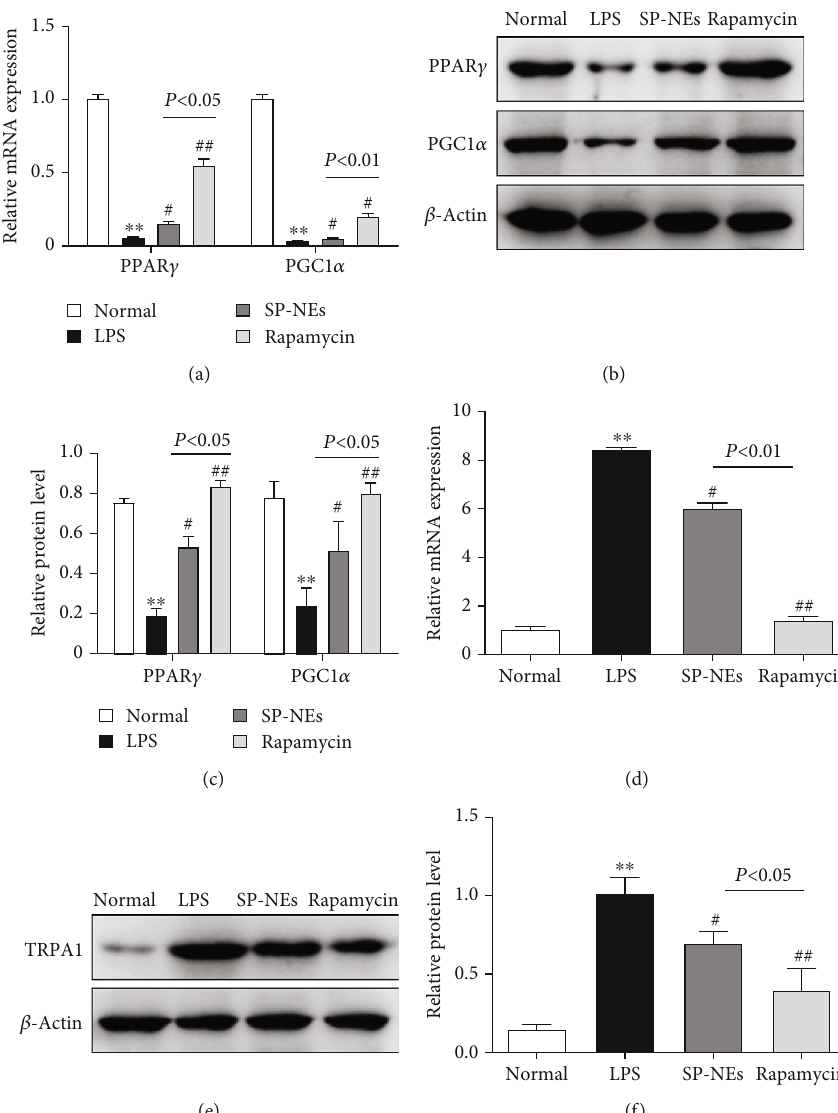
Figure 7: SP-NEs suppress TRPA1 though mTOR in LPS-stimulated FLSs. (a) Gene level of PPAR γ and PGC1 α in FLSs of each group. ∗∗ P < 0 : 01 vs. the normal, # P < 0 : 05 , ## P < 0 : 01 vs. the LPS, P < 0 : 05 , P < 0 : 01 , comparison between the underlined two groups. (b) Typical protein bands of PPAR γ and PGC1 α , in FLSs for each group. (c) Relative protein level of PPAR γ and PGC1 α for each group. ∗∗ P < 0 : 01 vs. the normal, # P < 0 : 05 , ## P < 0 : 01 vs. the LPS, P < 0 : 05 , comparison between the underlined two groups. (d). Gene level of TRPA1 in FLSs of each group. ∗∗ P < 0 : 01 vs. the normal, # P < 0 : 05 , ## P < 0 : 01 vs. the LPS, P < 0 : 01 , comparison between the underlined two groups. (e). Typical protein bands of TRPA1, in FLSs for each group. (f). Relative protein level of TRPA1 for each group. ∗∗ P < 0 : 01 vs. the normal, # P < 0 : 05 , ## P < 0 : 01 vs. the LPS, P < 0 : 05 , comparison between the underlined two